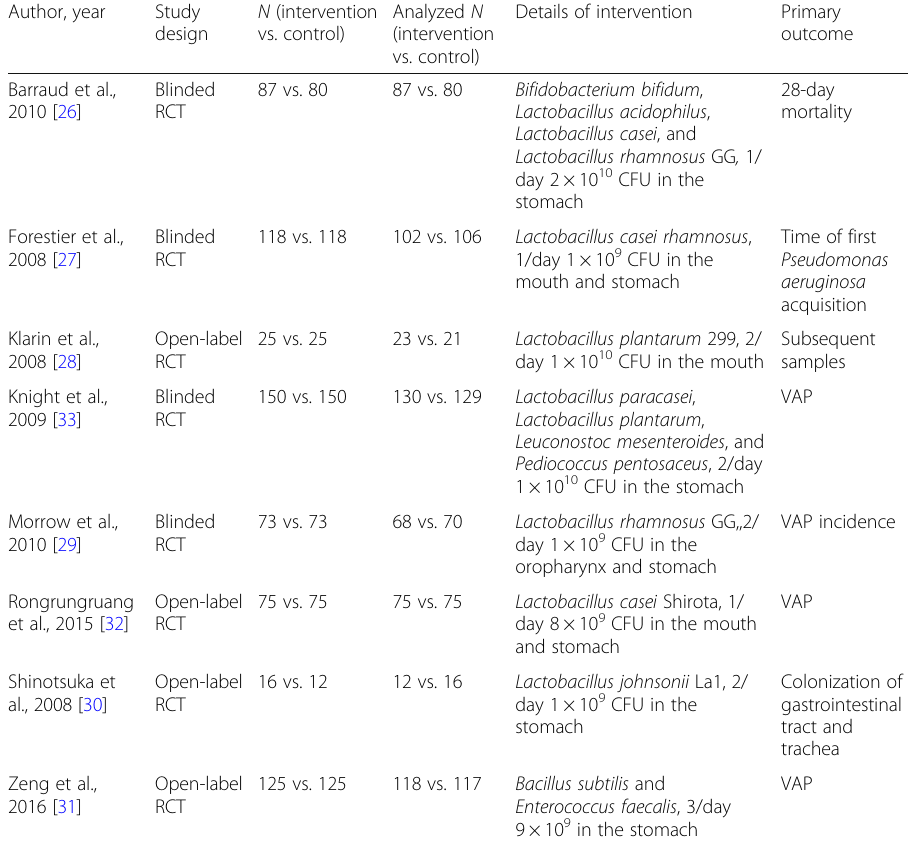
Table 1 Overview of the used definitions of VAP Author,